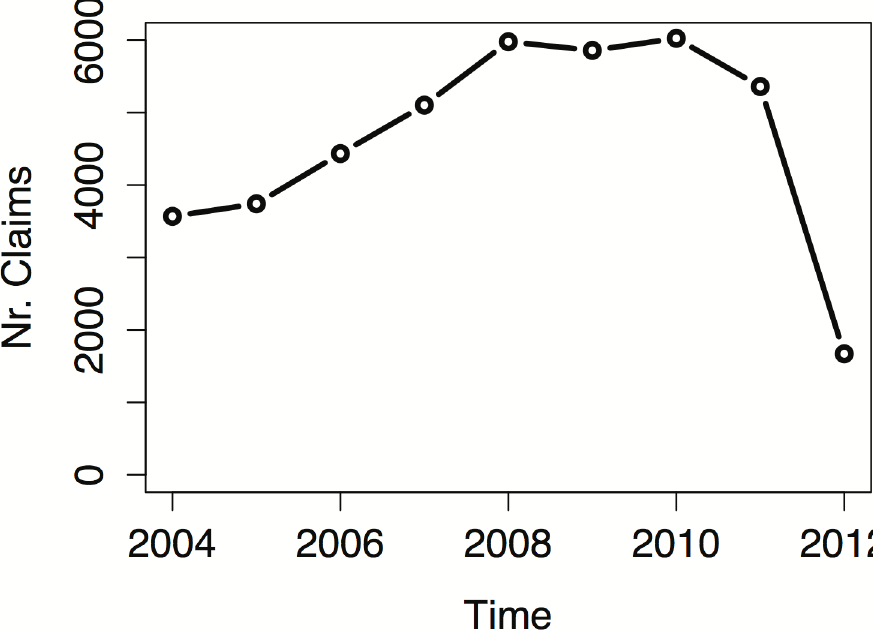
Fig 1. Total number of claims over time. Yearly number of claims for all regions pooled together (2004 – 2012).